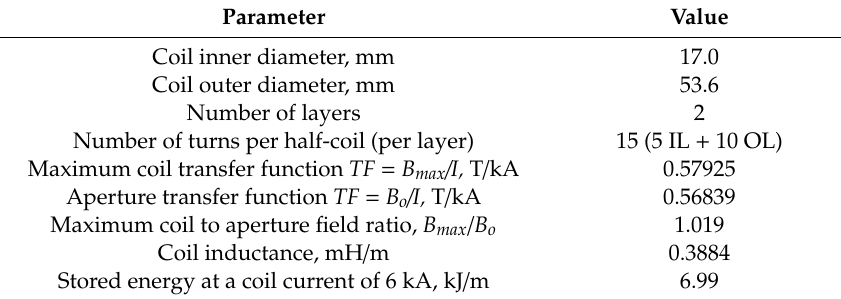
Table 2. Design parameters of the Bi2212 dipole